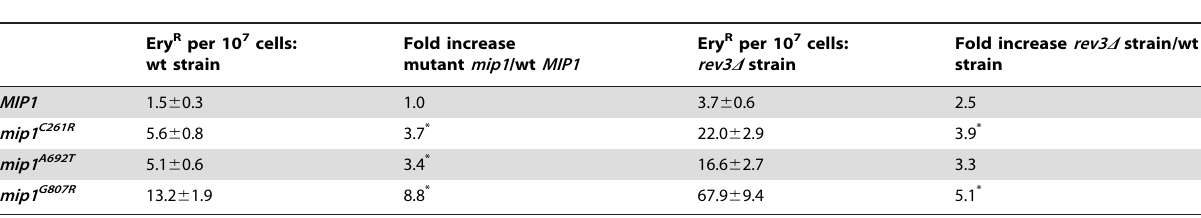
Table 2. Ery R mutant frequency in wt and rev3 D strains transformed with wt or mutant mip1 alleles.